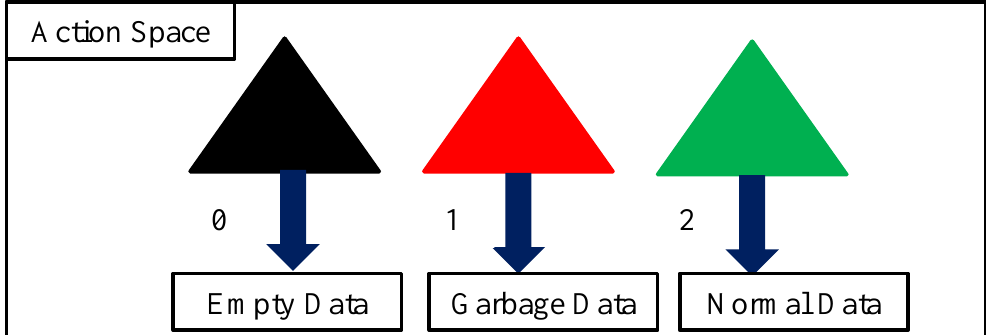
Figure 3. Possible three action spaces ( A P